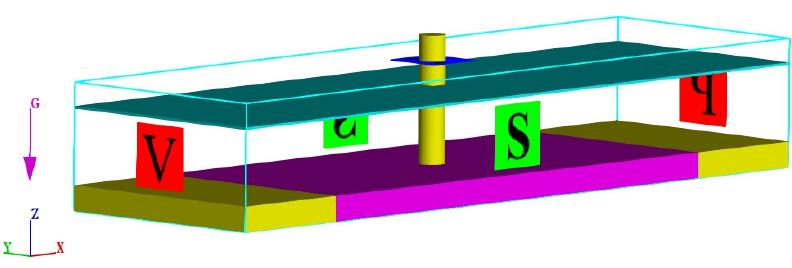
Figure 3. The boundary conditions of the model.